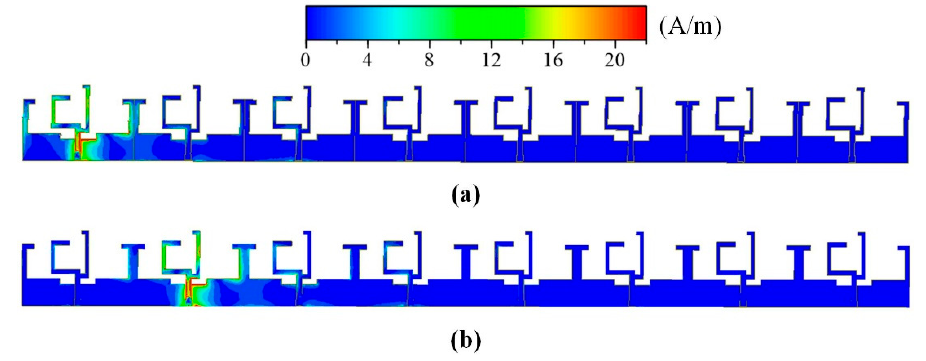
Figure 4. Simulation current distribution at 4.5 GHz: ( a ) Port 1 is excited; ( b ) port 2 is excited.